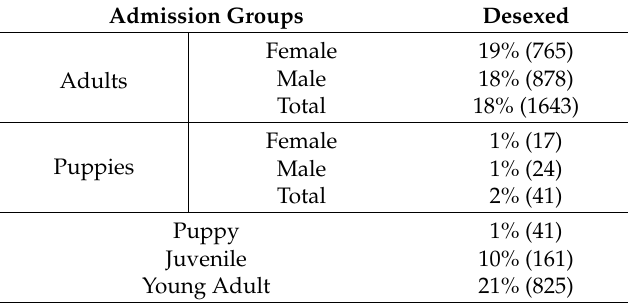
Table 2. Summary of desex status for 11,967 dogs admitted to RSPCA Queensland shelters in